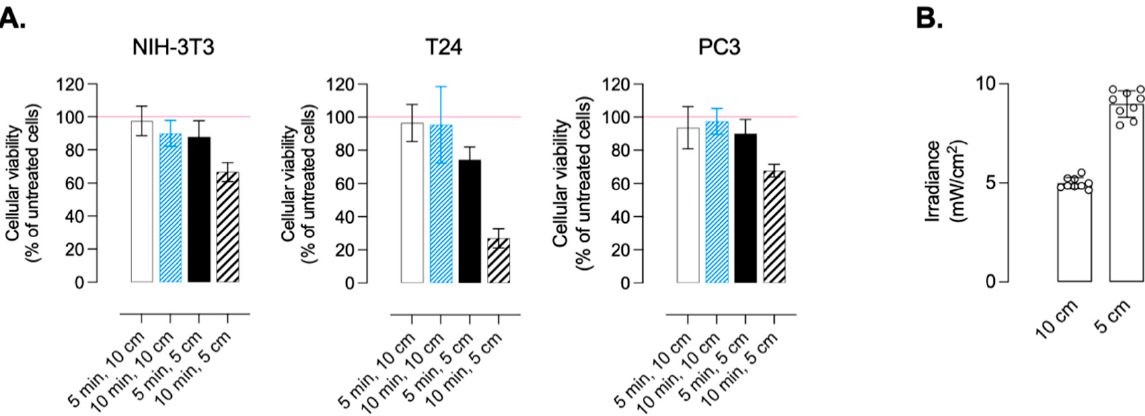
Figure 10. Validation of the conditions of irradiation ( A ) NIH-3T3, T24 and PC-3 cells were incubated for 72 h without drug, irradiated or not for 5 or 10 min, at 5 or 10 cm of distance. Cell death was assessed by MTT assay. Data are expressed as percentage (%) of cell viability compared with non- irradiated cells and are the means of 3 independent experiments. ( B ) Irradiance was quantified at a distance of 5 or 10 cm between the cell layer and the light source (458 nm) and expressed per unit of surface (mW/cm 2